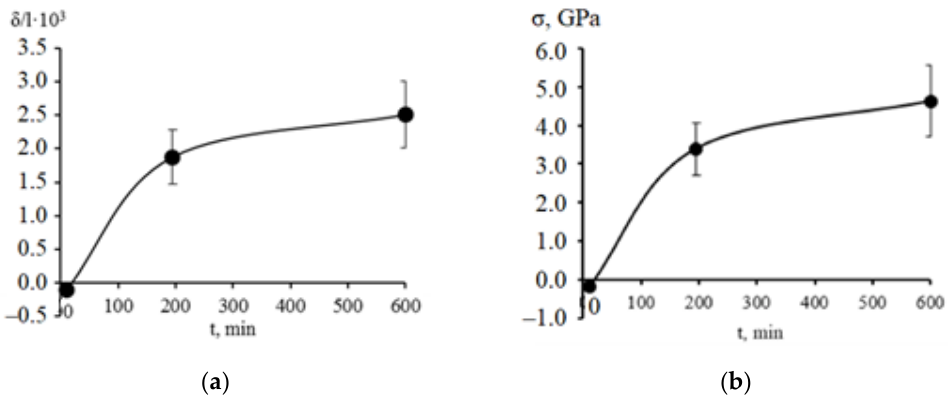
Figure 9. Change of average reduced normal curvature ( a ) and stresses in surface layer ( b ) of 20Kh13 steel samples without modification due to droplet impact of different duration at S imp = 250 m/s, d k = 150 µm.